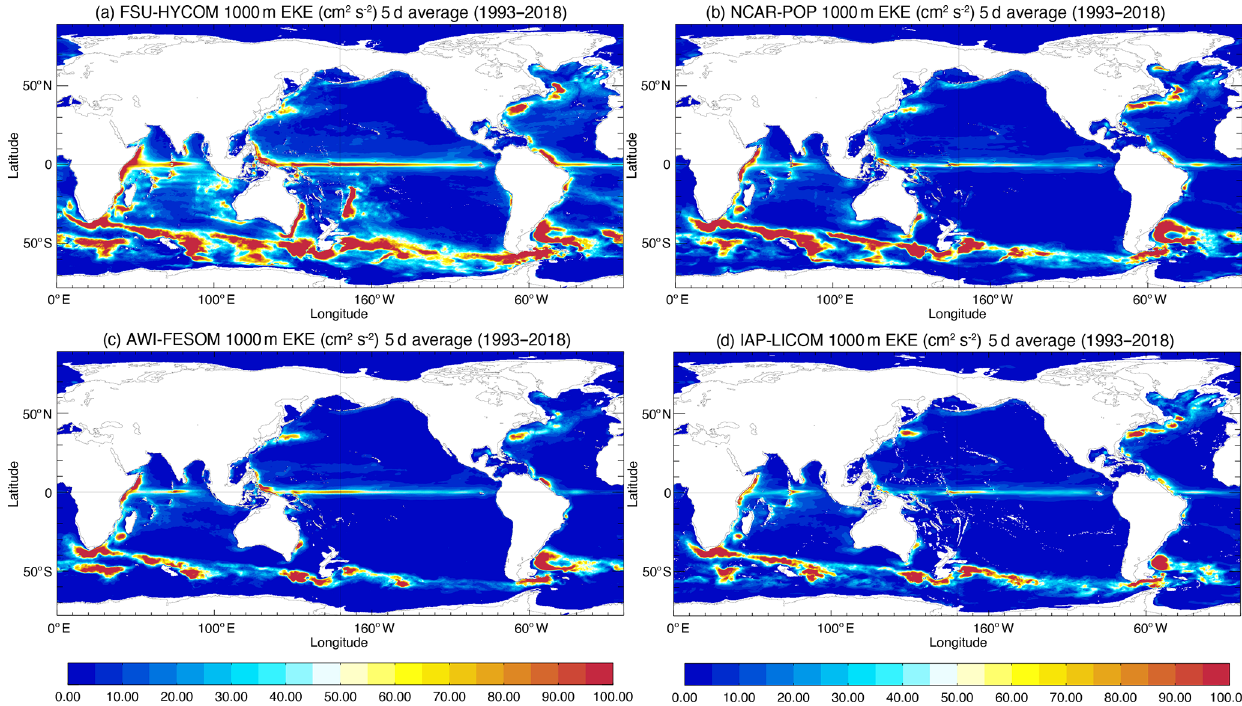
Figure 21. EKE at 1000m calculated from 5d average fields in (a) FSU-HYCOM, (b) NCAR-POP, (c) AWI-FESOM, and (d)